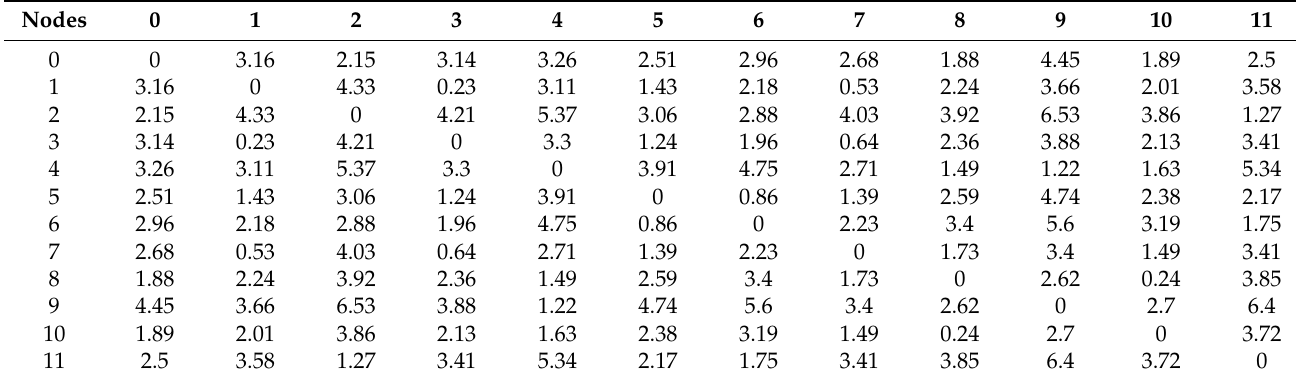
Table 2. Illustration of cost matrix between nodes in